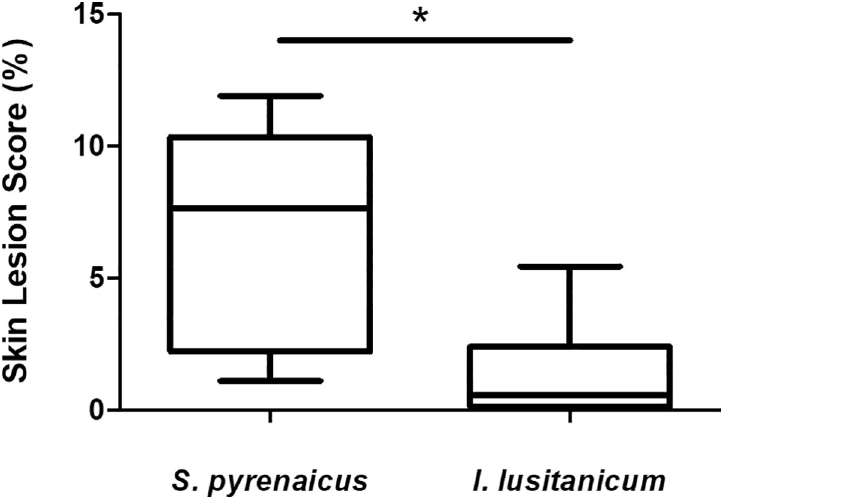
Fig 2. Skin lesion score (in %) in both analyzed species. � —p < 0.05.